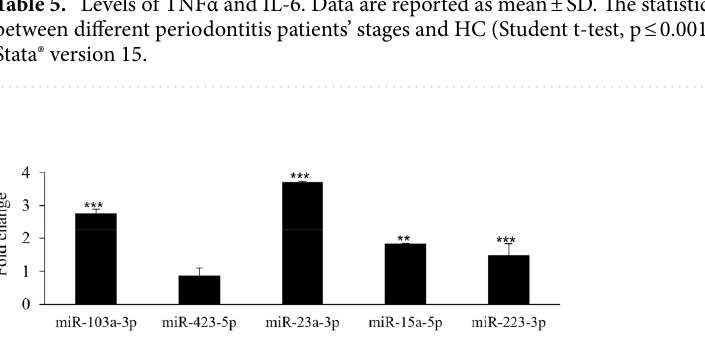
Figure 1. Relative expression levels of miRNAs detected in GCF of patients with periodontitis compared to HC. Data are reported as fold change ± C.I. with respect to HC, equal to 1. The statistical significances shown are **p < 0.01; ***p < 0.001. Data were analyzed using Stata version 15 and GraphPad Prism